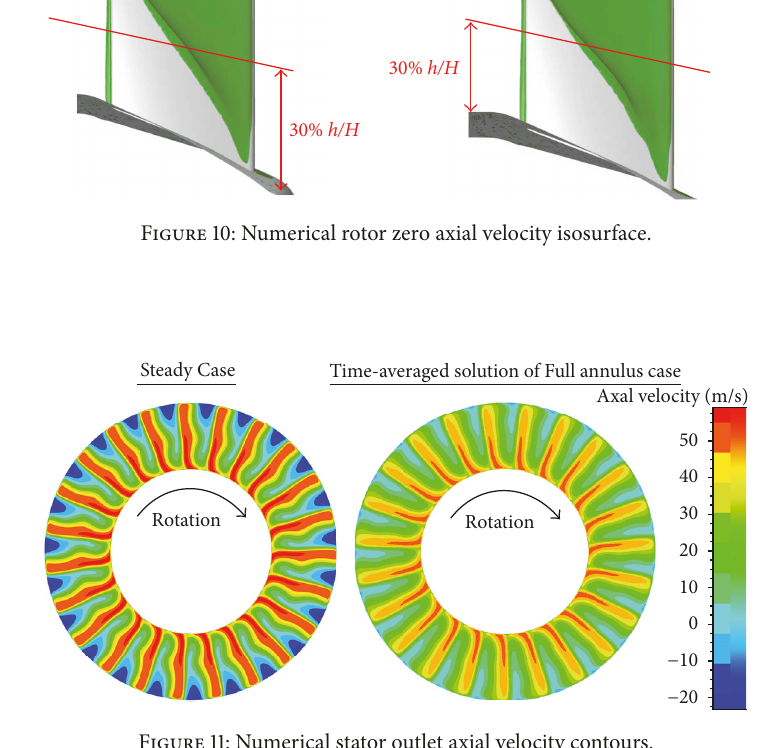
Figure 11: Numerical stator outlet axial velocity contours.